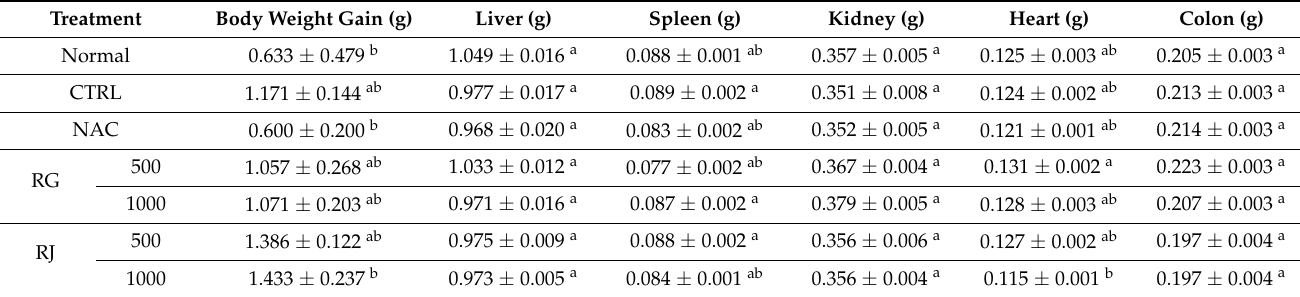
Figure 1. Effects of radish extracts on body weight and food intake in mice. The ( A ) body weight and ( B ) average of food intake for 4 weeks. Results are presented as means ± SE. Different letters represent groups that are significantly different from each other using ANOVA at p < 0.05 ( n = 7). CTRL, control; NAC, N-acetyl cysteine; RG, turnips of Ganghwa; RJ, radishes of Jeju. Table 3. Tissue weight of APAP-induced liver - damaged mice.